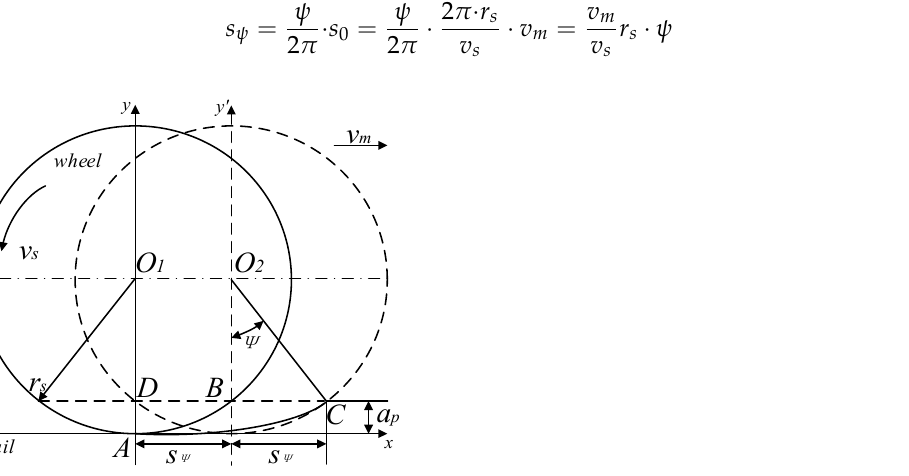
Figure 4. Schematic diagram of abrasive grain movement track. When the end face of the grinding wheel is perpendicular to the horizontal plane and only deviates from the longitudinal section of the rail by θ , the movement diagram of the grinding wheel is shown in Figure 5. Among these, the dotted line indicates the position of the grinding wheel after kinematic movement along the longitudinal direction of the rail when an abrasive grain is ground from point A to point C .